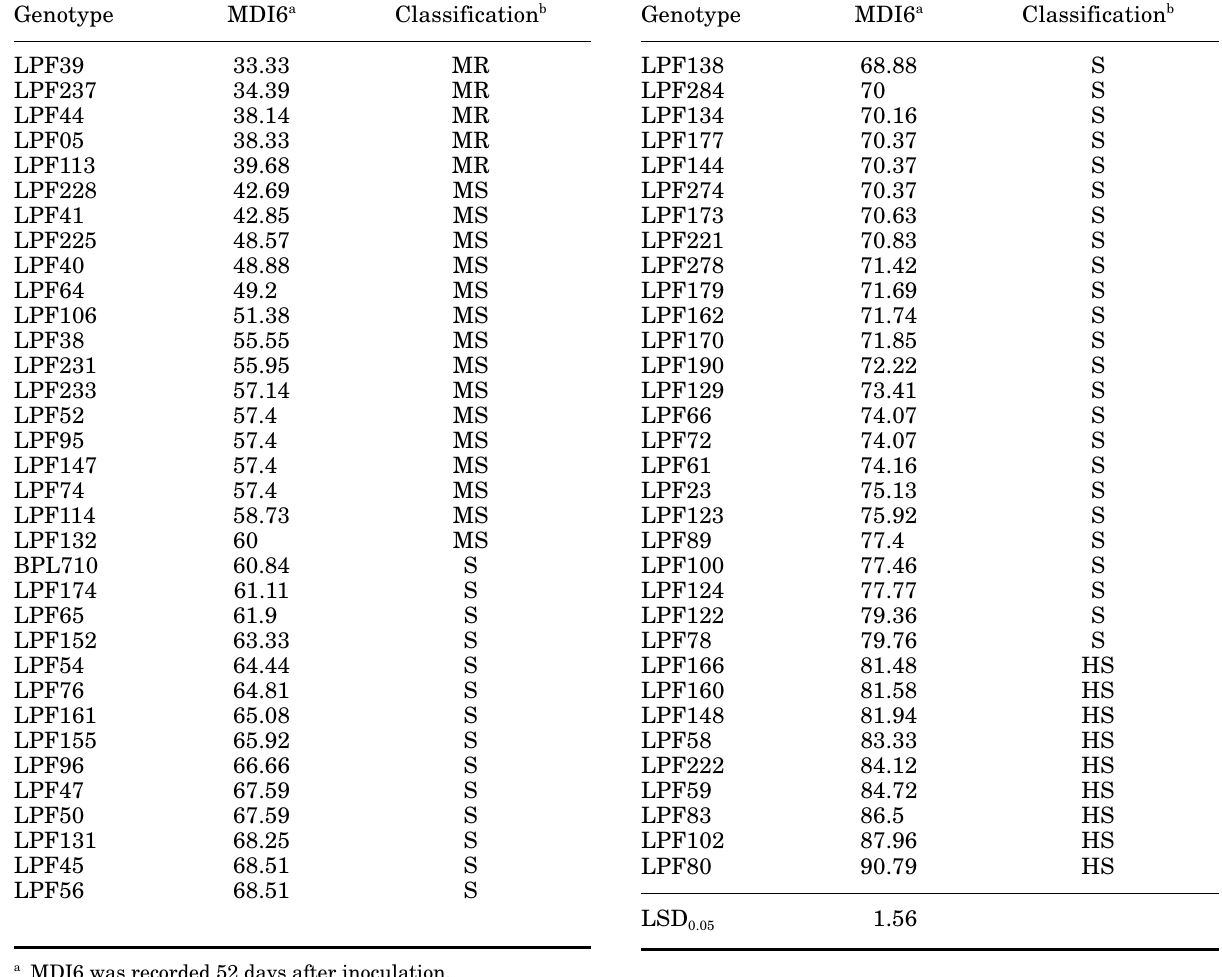
Table 2. Vicia faba reaction to chocolate spot according to mass disease index (MDI) values under field conditions. Genotype